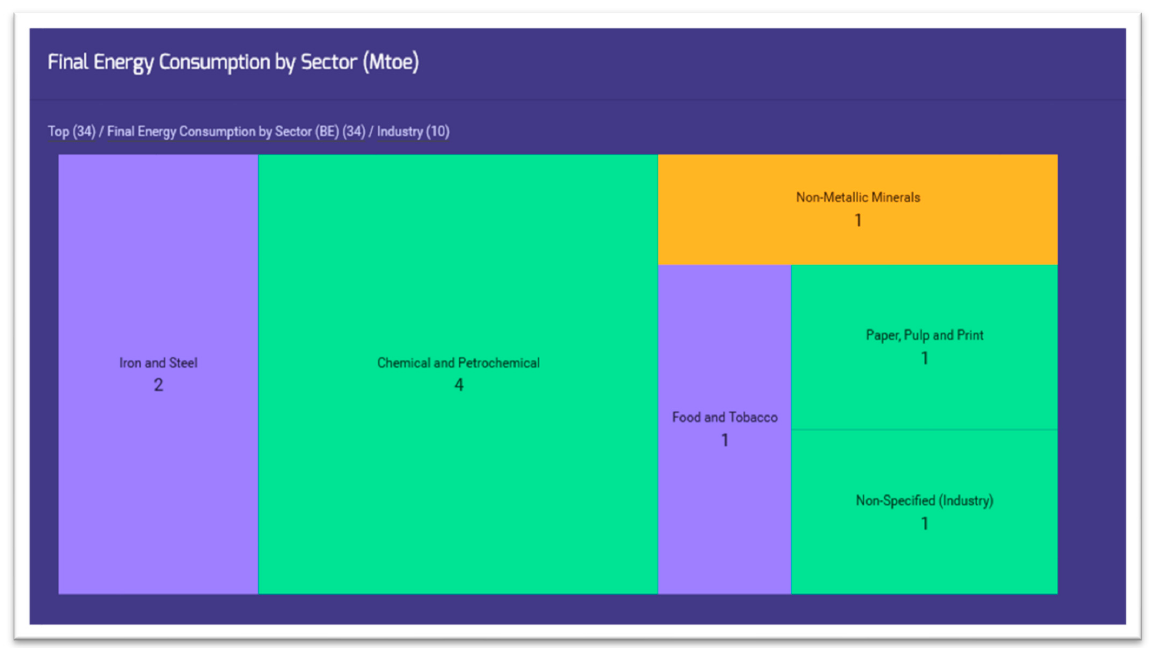
Figure 10. Treemap chart of final energy consumption by industry of an EU country.